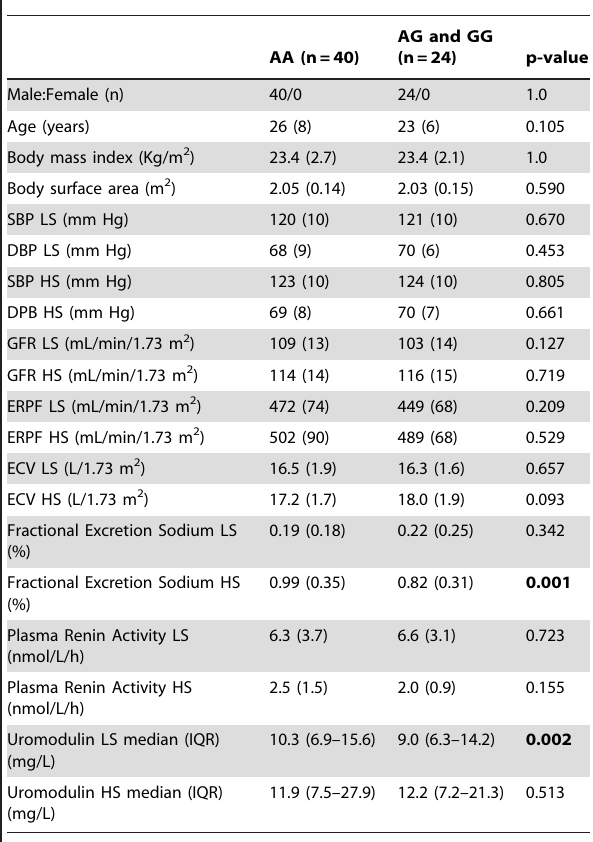
Table 6. Univariate association analysis of urinary uromodulin in relation to rs13333226 polymorphism and response to high and low sodium intake (GRECO